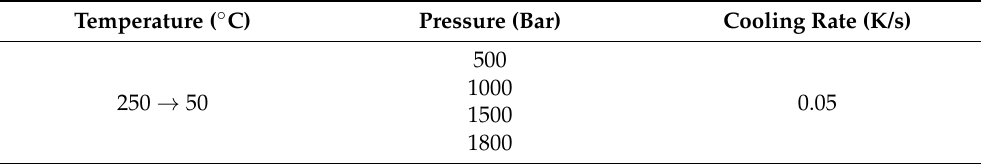
Table 2. PVT measurement processes of isobaric